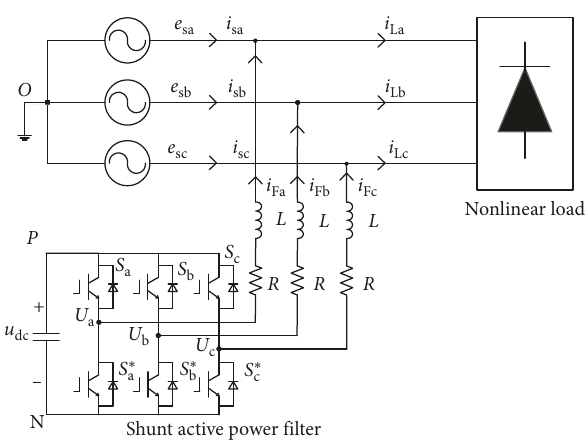
Figure 1: Structure of three-phase three-wire